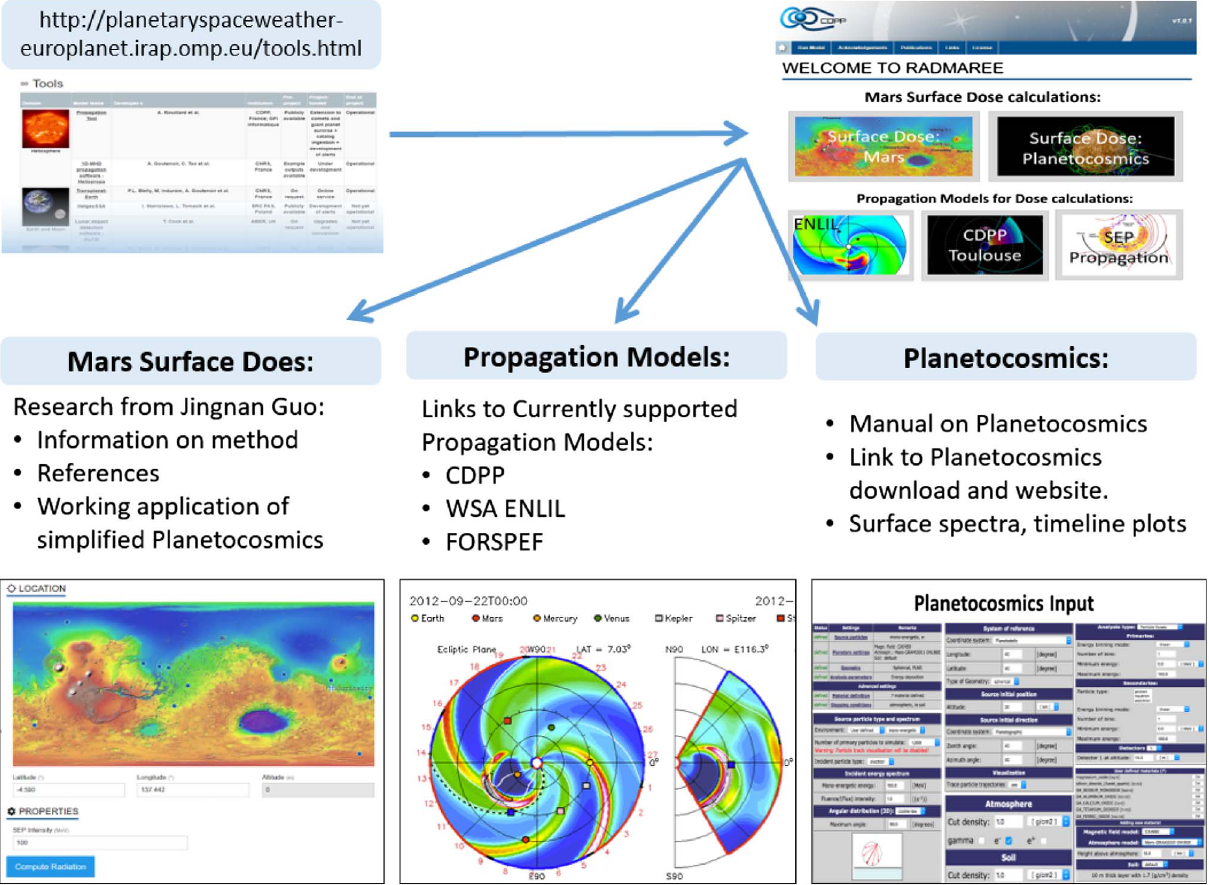
Fig. 5. The online interface of the RADMAREE implementation (http://radmaree.irap.omp.eu/) as part of the European planetary space weather